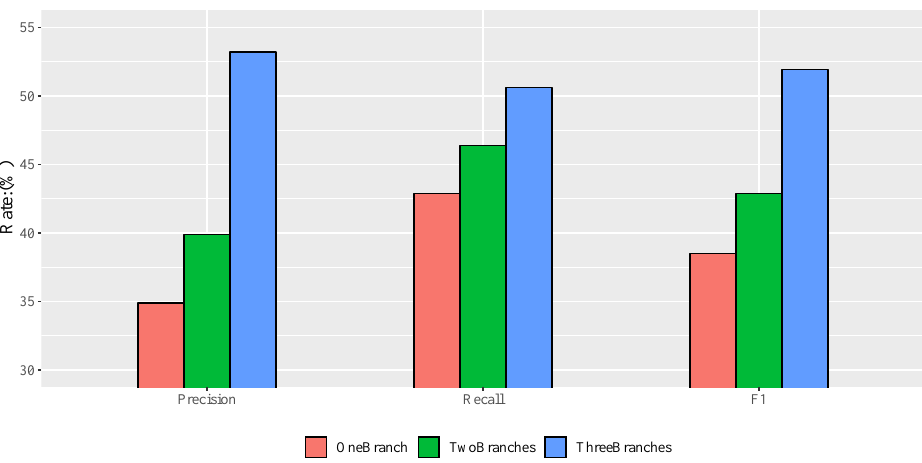
Figure 21. Comparison of detection results for different numbers of branch in Test Area